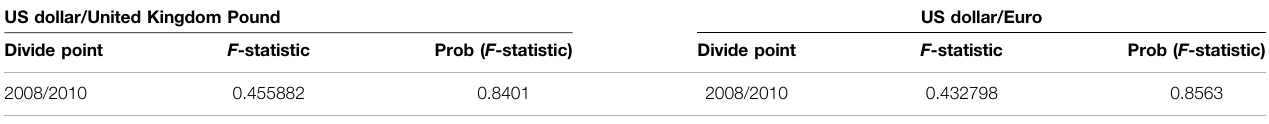
TABLE 6 | Chow test results for US dollar/UK pound and US dollar/Euro. US dollar/United Kingdom Pound